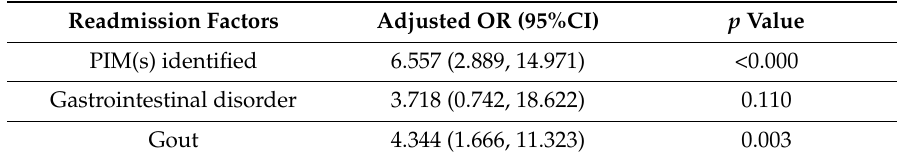
Table 5. Multiple logistic regression analysis of the association between early hospital